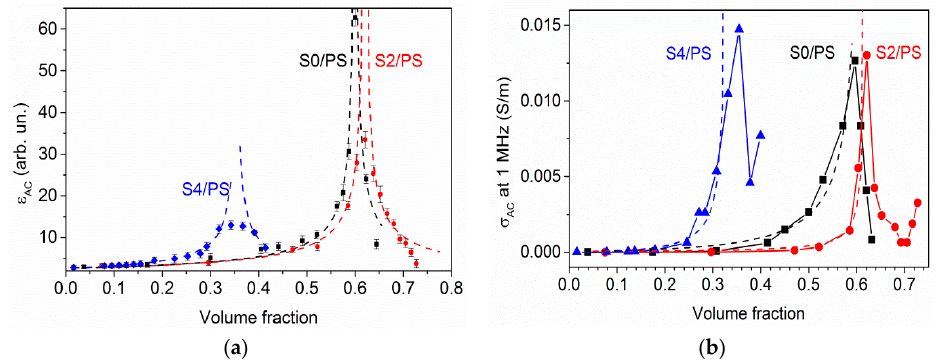
Figure 5. ε AC ( a ) and σ AC ( b ) of carbon nanohorn (CNH)/PS composites at 1 MHz. Dashed lines are the fitts of experimental data by Equations (2) and (3). the fitts of experimental data by Equations (2) and